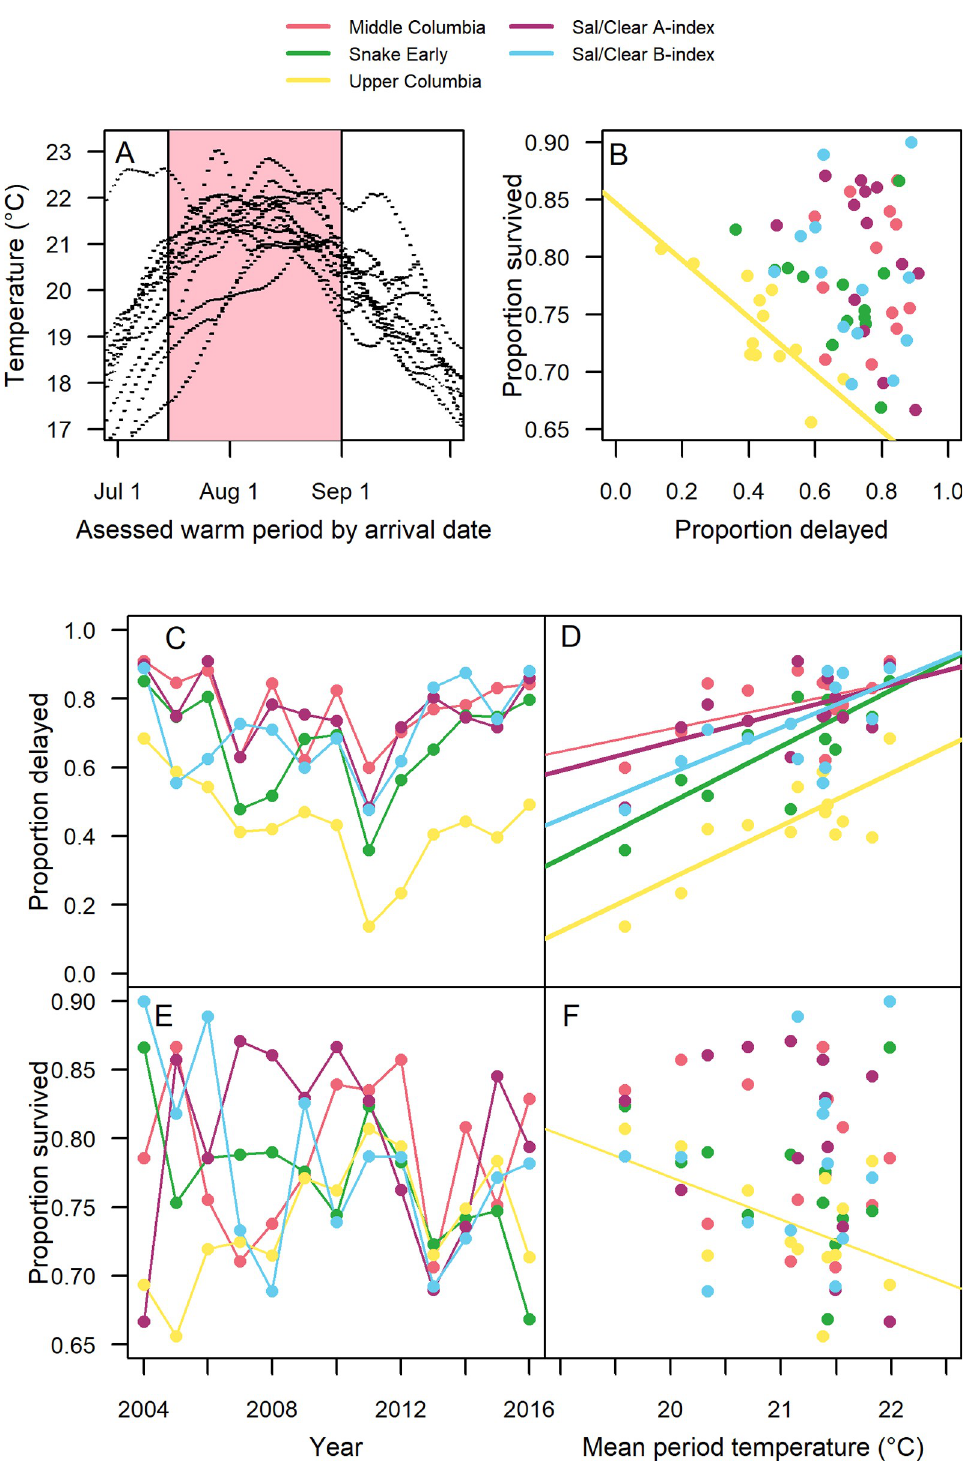
Fig 9. Interannual variability in behavior and survival. Interannual variability in the proportion delayed and survival by year assessed for the July 15th-Septeber 1st warm period when fish were most likely to delay migration (A). Panel B shows a direct comparison between the proportion delayed and the proportion that survived (B). The mean proportion of migrants that delayed (C) and the proportion that survived the reach (E) are shown by year and compared to the average reach temperature (D and F) for each population group. Significant linear model relationships are shown with thick ( P < 0.05) or thin ( P < 0.1 & > 0.05) solid lines (B, D and F). https://doi.org/10.1371/journal.pone.0250831.g009 PLOS ONE | https://doi.org/10.1371/journal.pone.0250831 May 10,